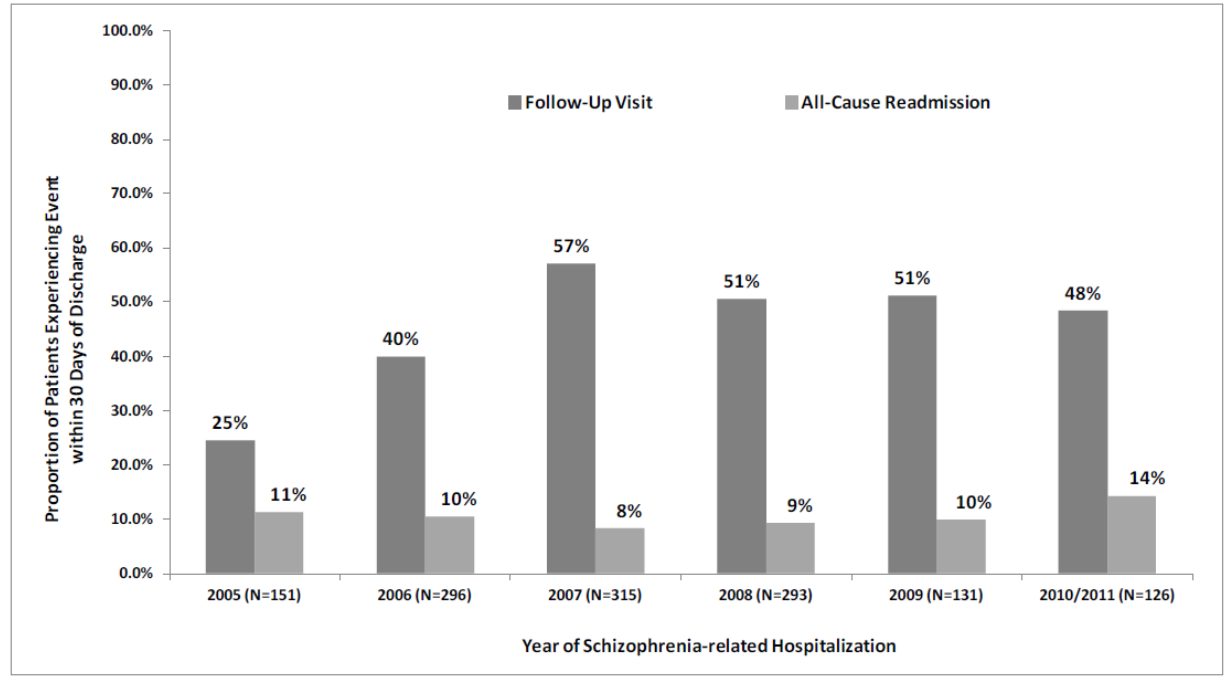
Figure 2. Proportion of Patients with an Outpatient Follow-up Visit or Readmission within 30 Days of Discharge by